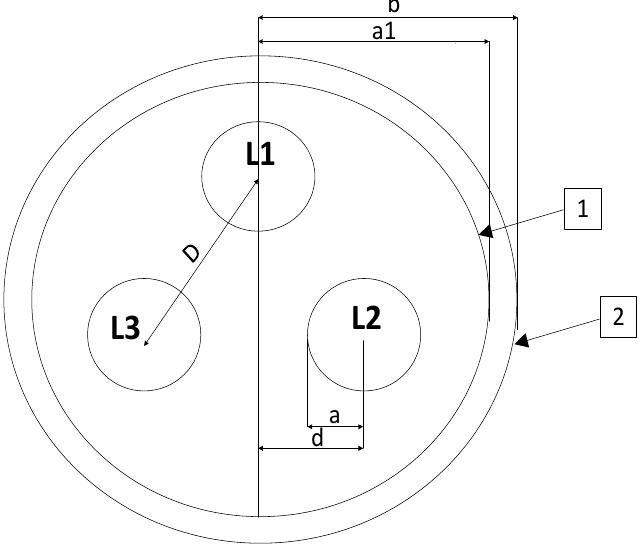
Figure 2. Cross-sectional view of the 3-phase 6 kV power cable: 1–screen (made of copper), 2–armor (steel composition), L1, L2, L3–phase conductors (made of copper); a = 15 mm, D = 46.96 mm, b = 63 a1 = 55 mm, d = 23.48 mm; screen material conductivity: 58.67 × 10 6 1 / Ω m, armor material conductivity: mm, a1 = 55 mm, d = 23.48 mm; screen material conductivity: 58.67 × 10 6 1/ Ω m, armor material 10.02 × 10 6 1 / Ω m, polyvinyl as an insulating filing medium: 10 − 14 1 / Ω m; electric permittivity of conductivity: 10.02 × 10 6 1/ Ω m, polyvinyl as an insulating filing medium: 10 − 14 1/ Ω m; electric polyvinyl: 3.3; magnetic permeability of copper 0.9999, steel composition: permittivity of polyvinyl: 3.3; magnetic permeability of copper 0.9999, steel composition: 60.